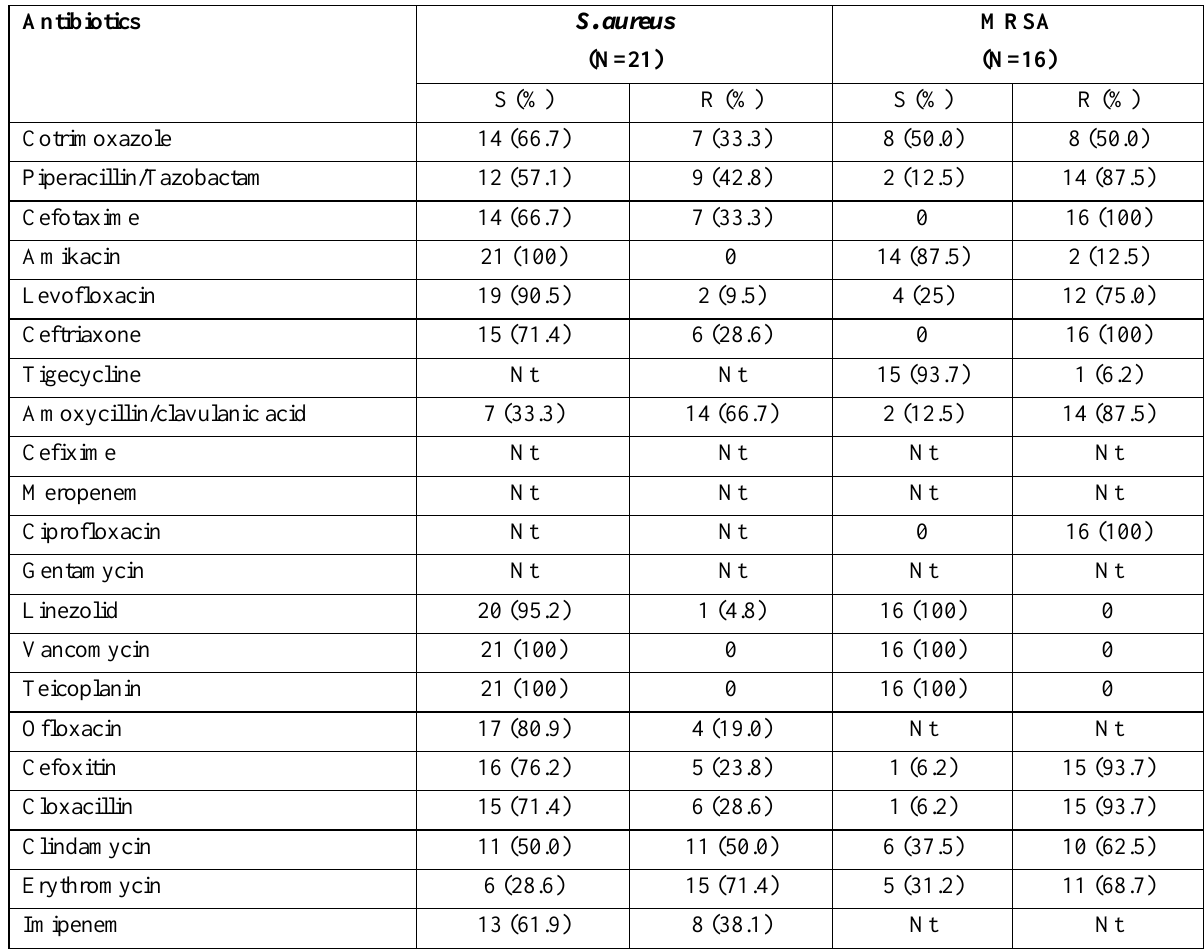
Table 3. Antibiotic susceptibility pattern of the Gram positive pyogenic isolates.